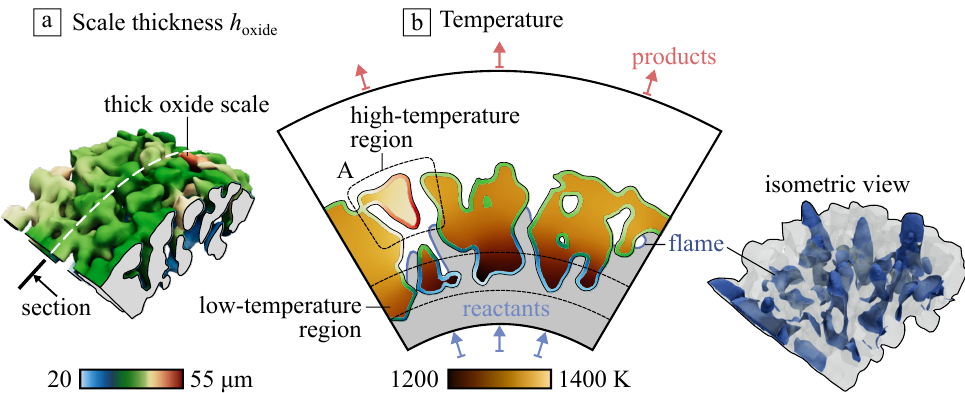
Figure 8. ( a ) Al 2 O 3 scale thickness at the Ni-Al porous material in the case of submerged flame formed during 100 h and ( b ) the temperature distribution in central section appended by the scale thickness h oxide .